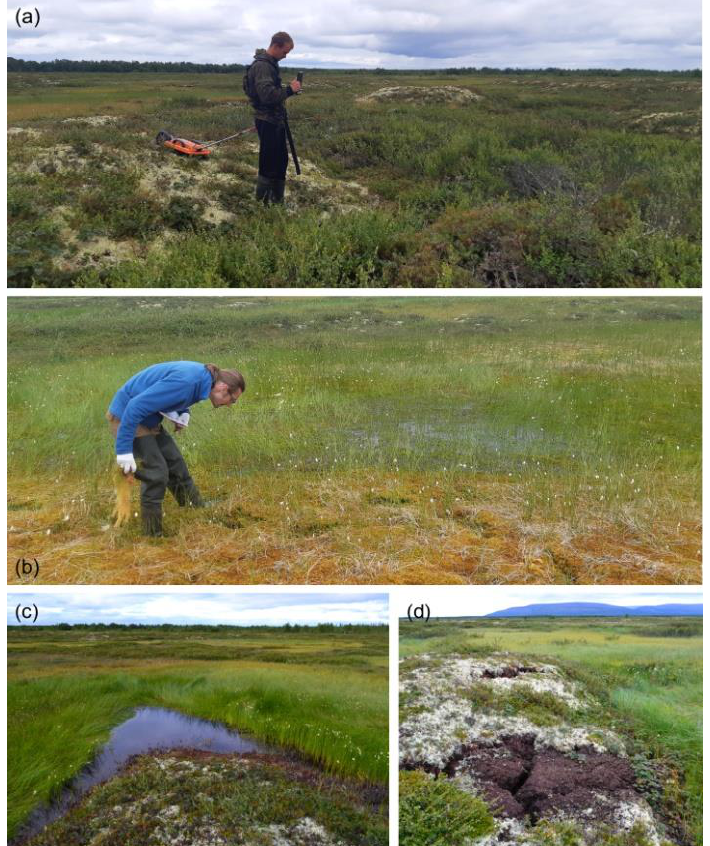
Figure 2. Photographs from fieldwork on Lovozero mire: GPR surveying of palsas ( a ), relevé sampling in a flark ( b ), meltwater accumulation area with the associated vegetation succession ( c ), peat erosion area on hummock slope ( d ).